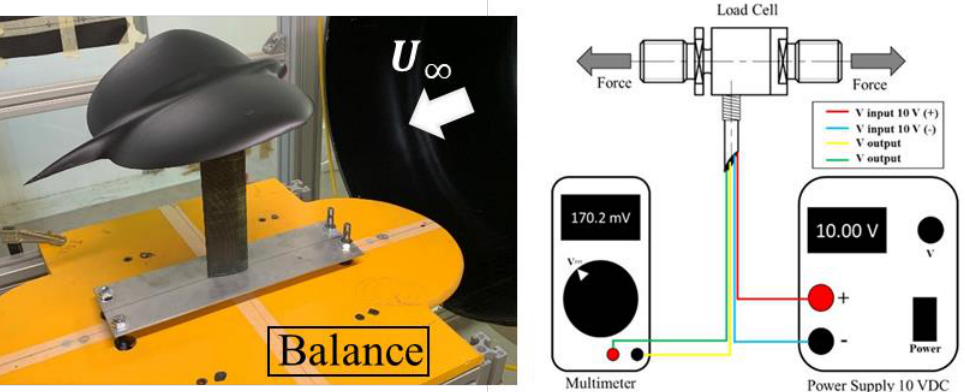
Figure 14. MAV attached to the balance ( left ) and electrical connections of load cell to multimeter and power supply ( right ).